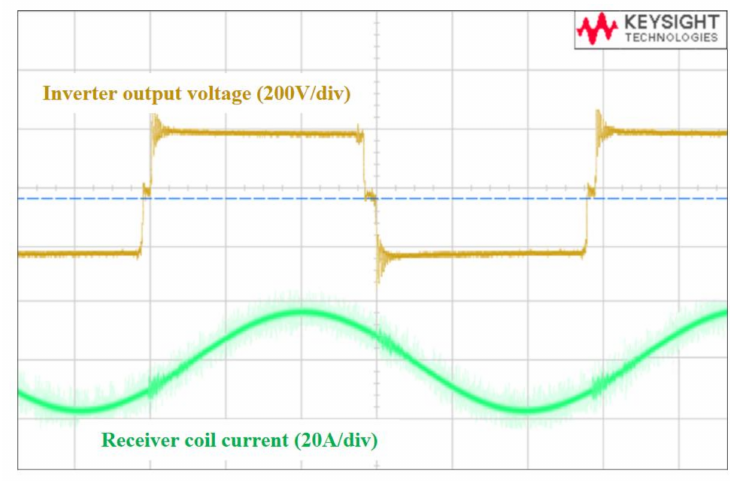
Figure 14. Full-bridge output voltage and receiver coil current.